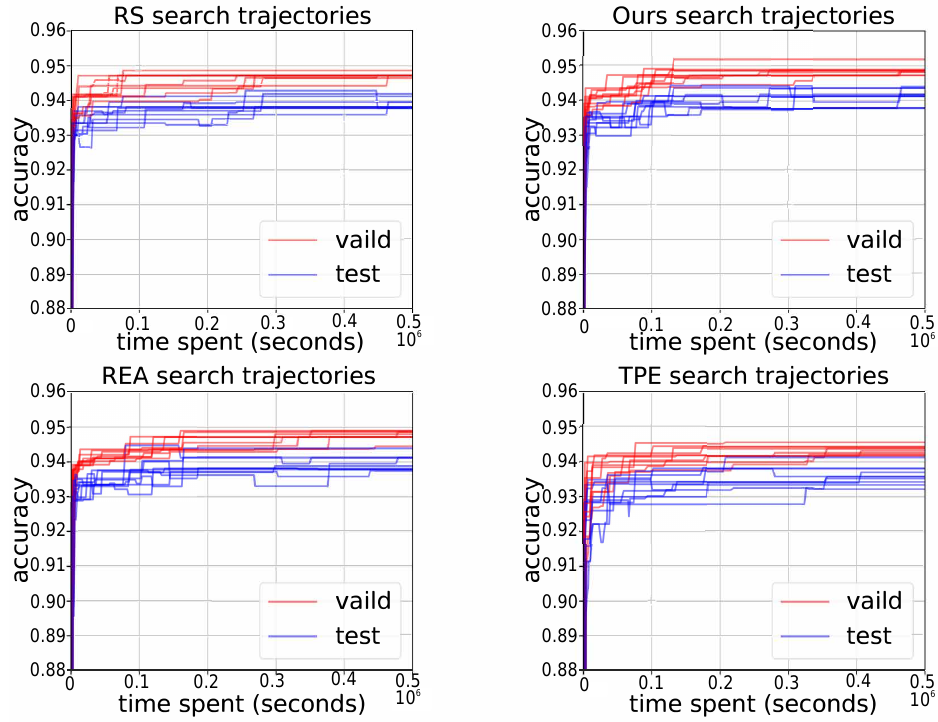
Figure 2. Search trajectories of Random search, REA, and QDO on NAS-Bench-101.